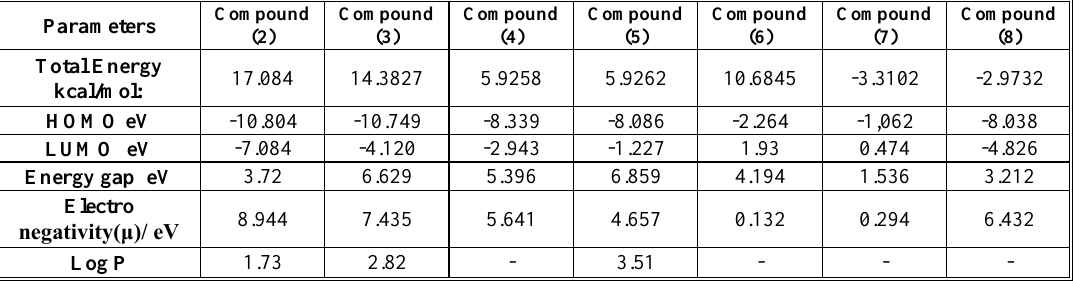
Table 3. HOMO and LUMO, and electronic properties units for compounds (2-8) using DFT with B3LYP/6-B3LYP/6-31G* basis